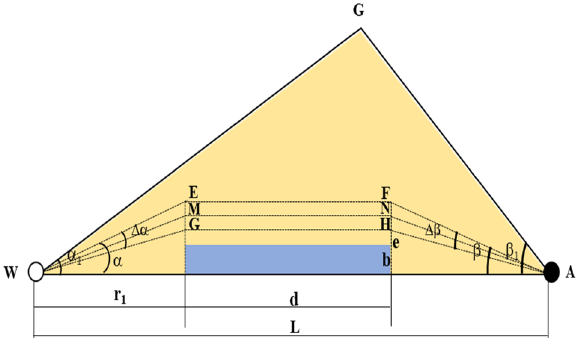
Figure 5. Seepage unit of rhombic inverted nine-spot well pattern, calculation unit of area sweep coefficient, schematic diagram of flow pipe in the calculation unit .